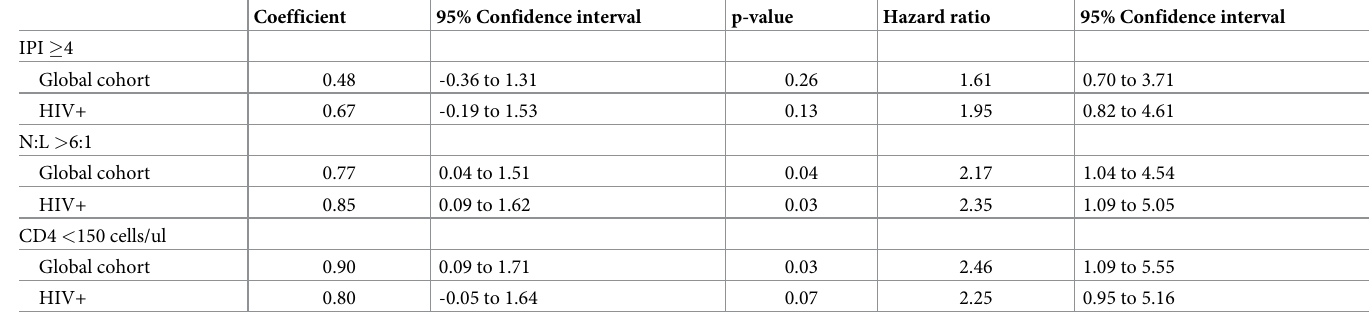
Table 6. Cox proportional-hazards regression analysis for independent associations between the survival time and the IPI, CD4 count and a N:L > 6:1. Coefficient